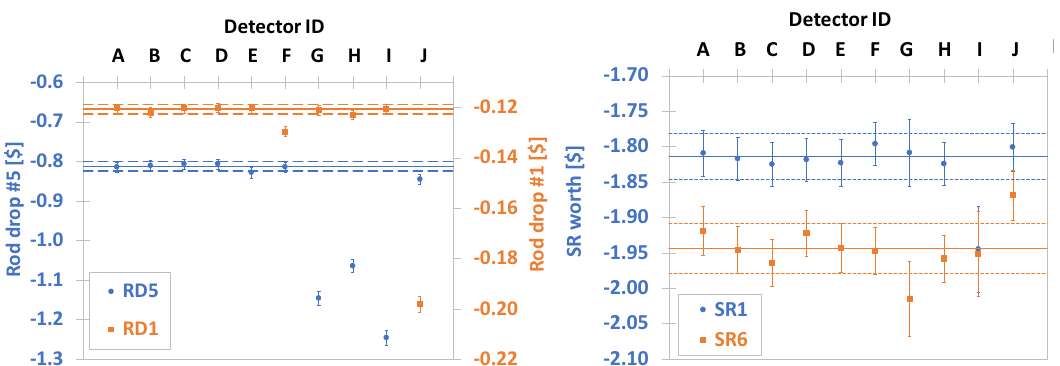
Figure 2. Left: Rod drop in positions 1 and 5 measured with ten detectors (for the detector locations, see left part of Fig. 1). The solid and dashed lines represent average and 1 (cid:4)(cid:4) uncertainties (excluded detectors: F, J for RD1, G, H, I , J for RD5). Right: SR1 and SR6 worth measured with ten detectors and using RD5 as a reference sub-critical configuration. The solid and dashed lines represent average and 1 (cid:4)